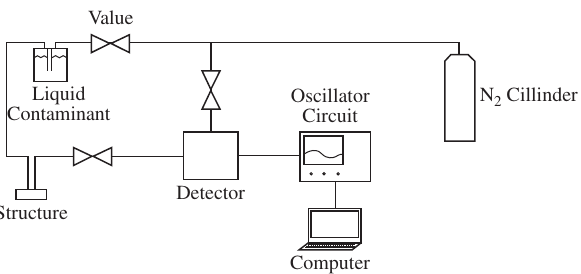
Figure 1. Schematic diagram for the experimental setup used for QCM in gas phase. The meaning of structure is microchannel or cavity.